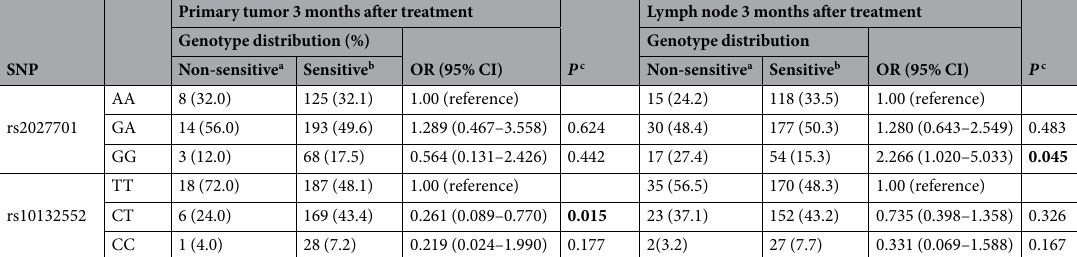
to titrate miRNAs 27,28 . The variation in the rs1829346 sequence may create a new binding site for miR-1304 ( Supplementary Table S3 ) , inhibiting the expression of TUSC7 , regulating cell proliferation proteins and ulti- mately leading to a higher risk of CRT-induced dermatitis. For rs36080650, although there is no direct evidence to illustrate its function, the strong linkage disequilibrium (LD) with rs1829346 suggested that the regulation of gene expression is not mediated by this SNP but by a variant in rs1829346.